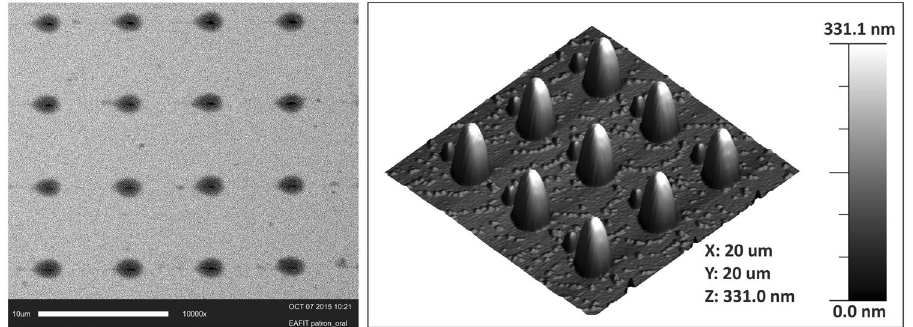
Figure 2. SEM (left) and AFM (right) images of polymeric column pattern on gold.